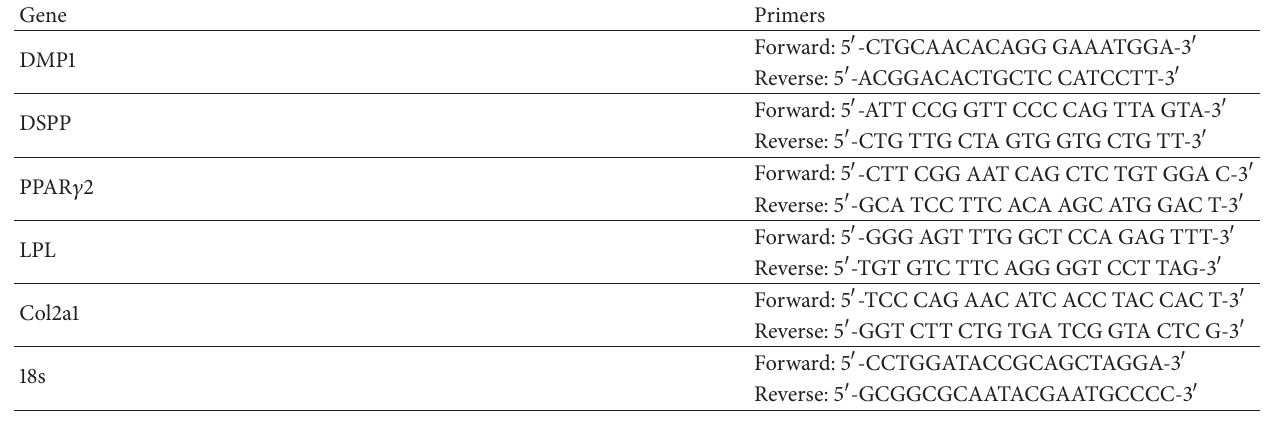
Table 2: Primer sequences used in quantitative real-time polymerase chain reaction.